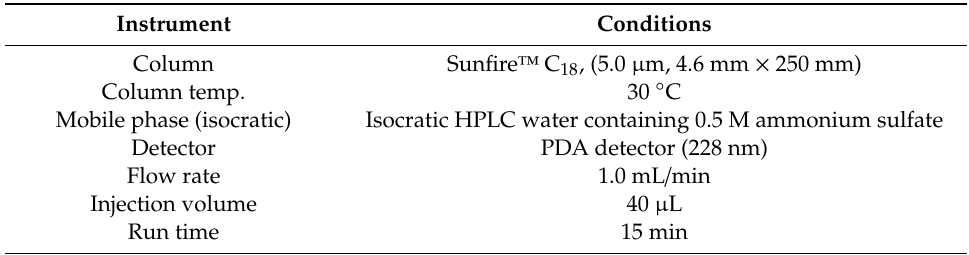
Table 2. HPLC condition for analysis of